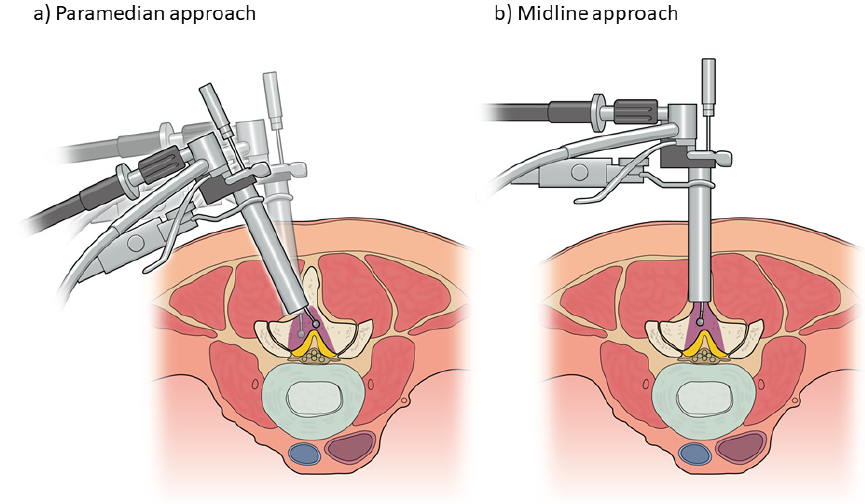
Figure 3. Schematic presentation of the ( a ) paramedian approach and ( b ) midline approach in microendoscopic lumbar decompression.